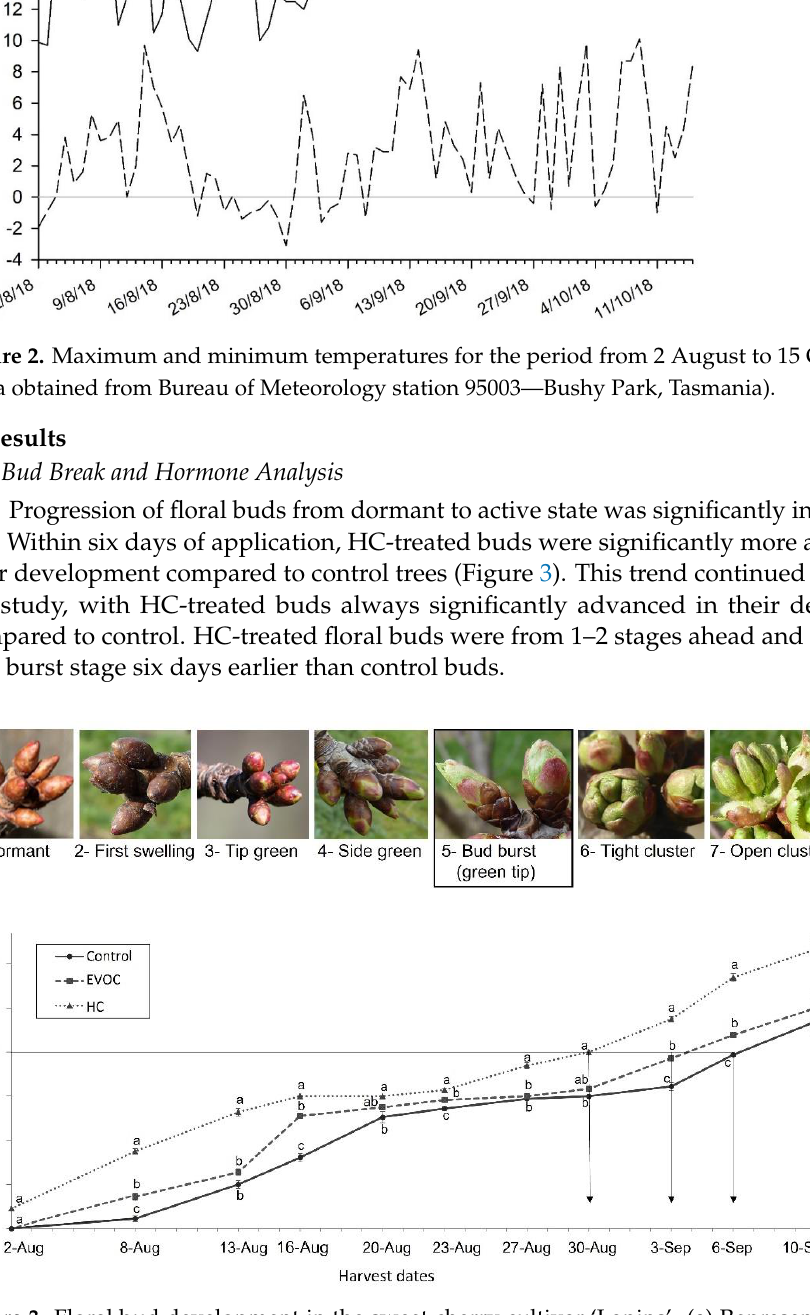
Figure 3. Floral bud development in the sweet cherry cultivar ‘ Lapins ’ . ( a ) Representative stages of floral bud development and ( b ) floral bud stage over time of cherry trees treated with dormancy breakers hydrogen cyanamide (HC) and emulsified vegetable oil compound (EVOC) compared to control; arrows indicate the date that buds reached bud burst (stage 5). For ( b ) values are mean ± standard error (s.e.) ( n = 4 branches, with 10 buds per branch); at each time point values with different letters are significantly different ( p <